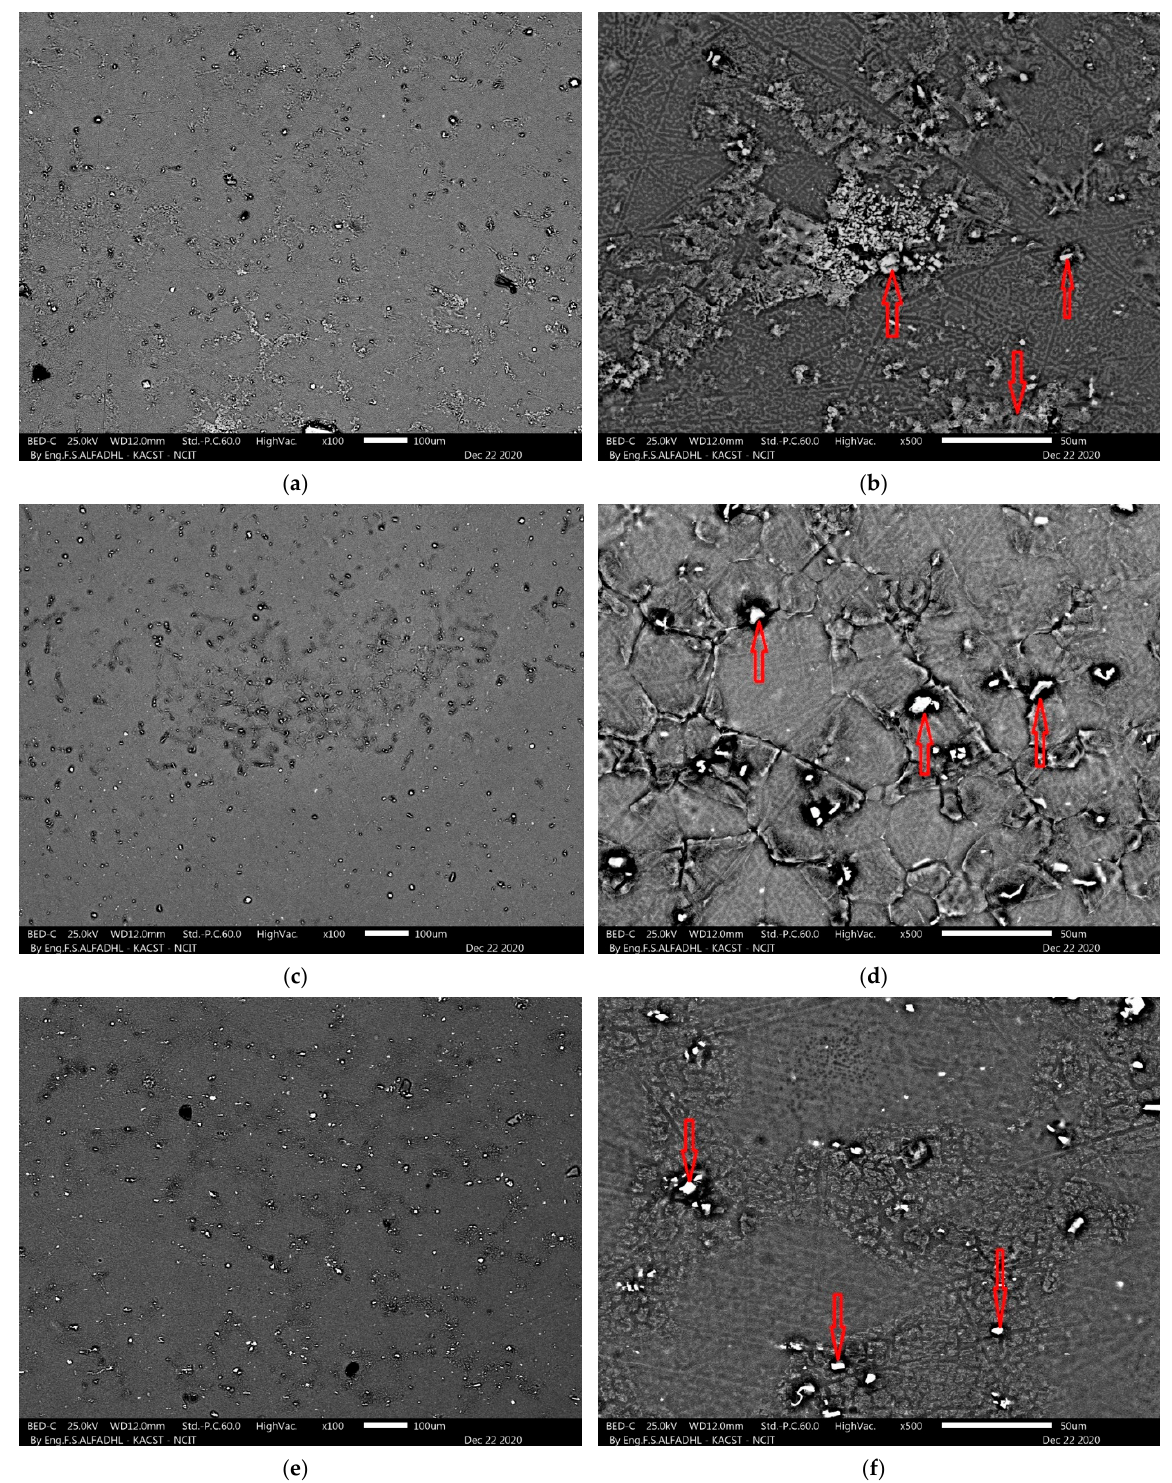
Figure 2 . Optical microscopy (OM) micrographs of the AZ31 alloy after ECAP processing ( a,b ) as-annealed condition (AA), ( c ) ECAP processed through 1 pass (1-P), and ( e,f ) 2 passes of route Bc (2-Bc) (arrows indicate the secondary phase particles) .